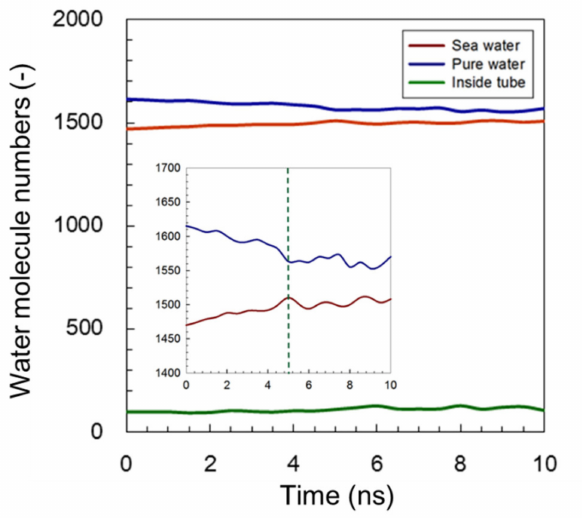
Figure 3. Time course for the number of water molecules during FO simulation when using a common AmBEr channel ( d = 12 Å). Inserted figure shows the enlarged vertical